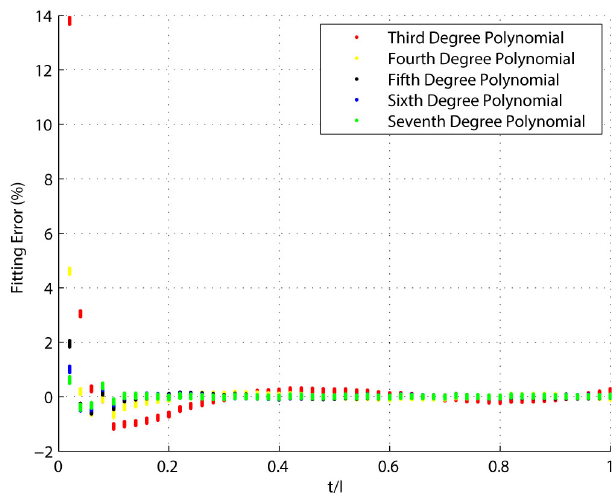
Figure 10. Fitting